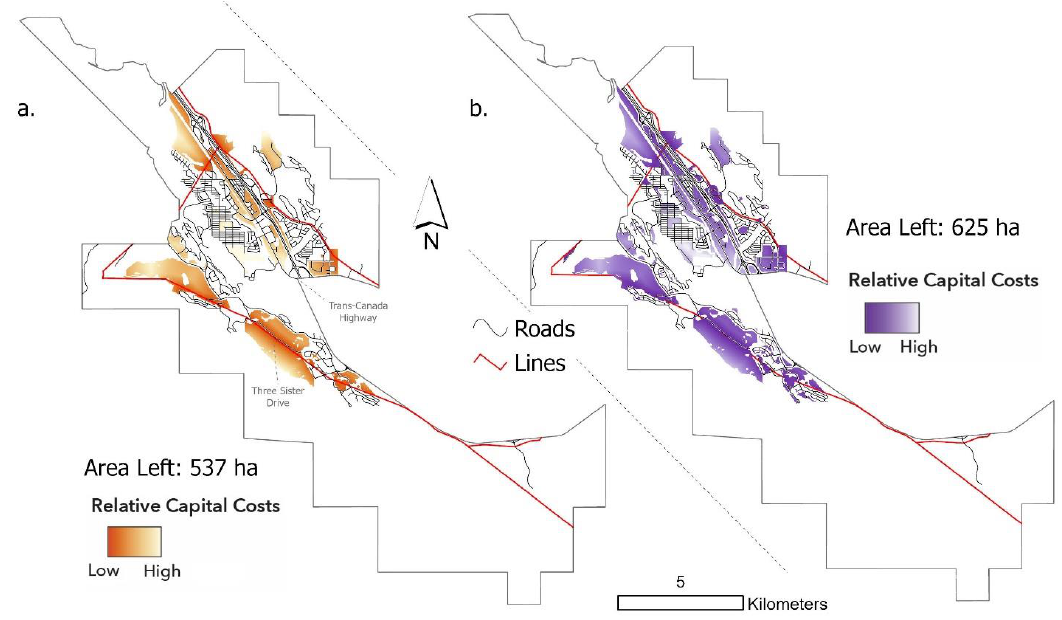
Figure 6. Relative capital cost of connecting those resources to existing roads and lines after constraint applied for ( a ) solar and ( b ) wind opportunities. Constraints include technically recoverable resources and those semi-permissive lands under legally accessible resources.